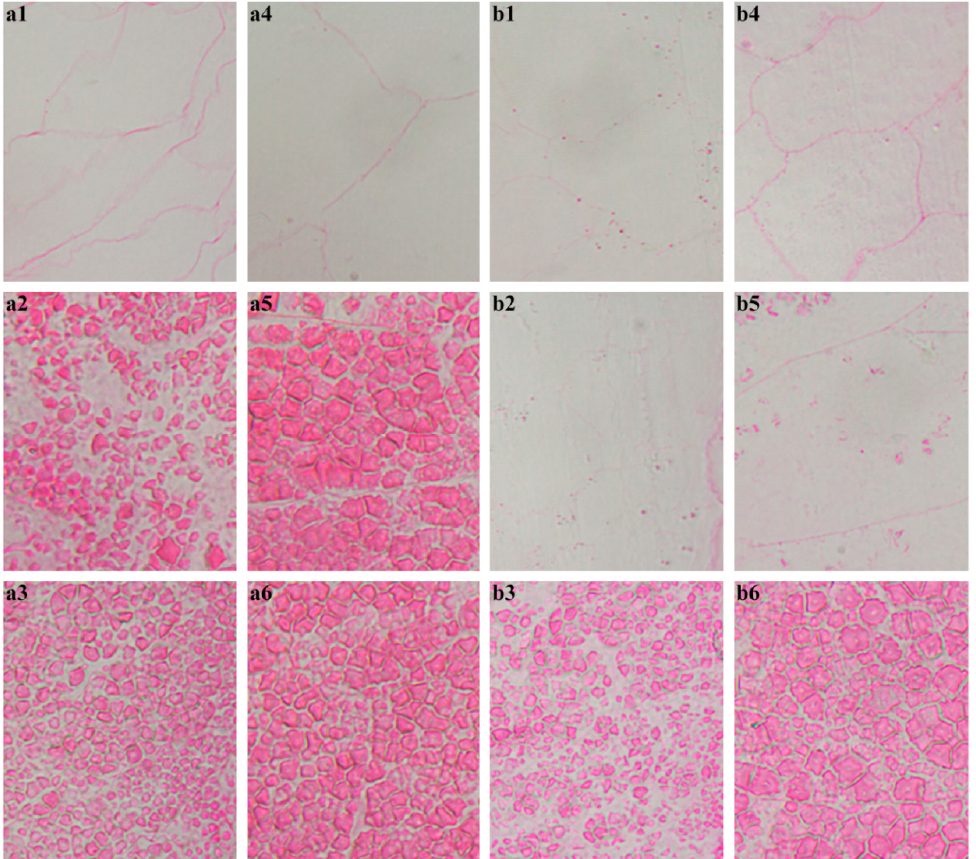
Figure 6. The longitudinal section of the whole kernel during seedling growth. The section is stained with Schiff ′ s reagent. Scale bar = 2 mm.